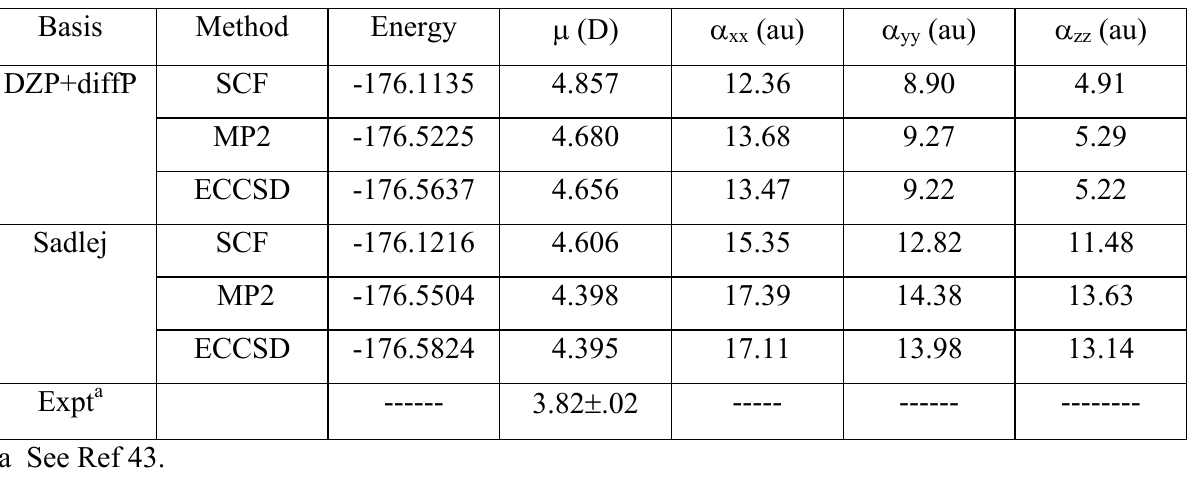
Table 5. Properties of HF- Water